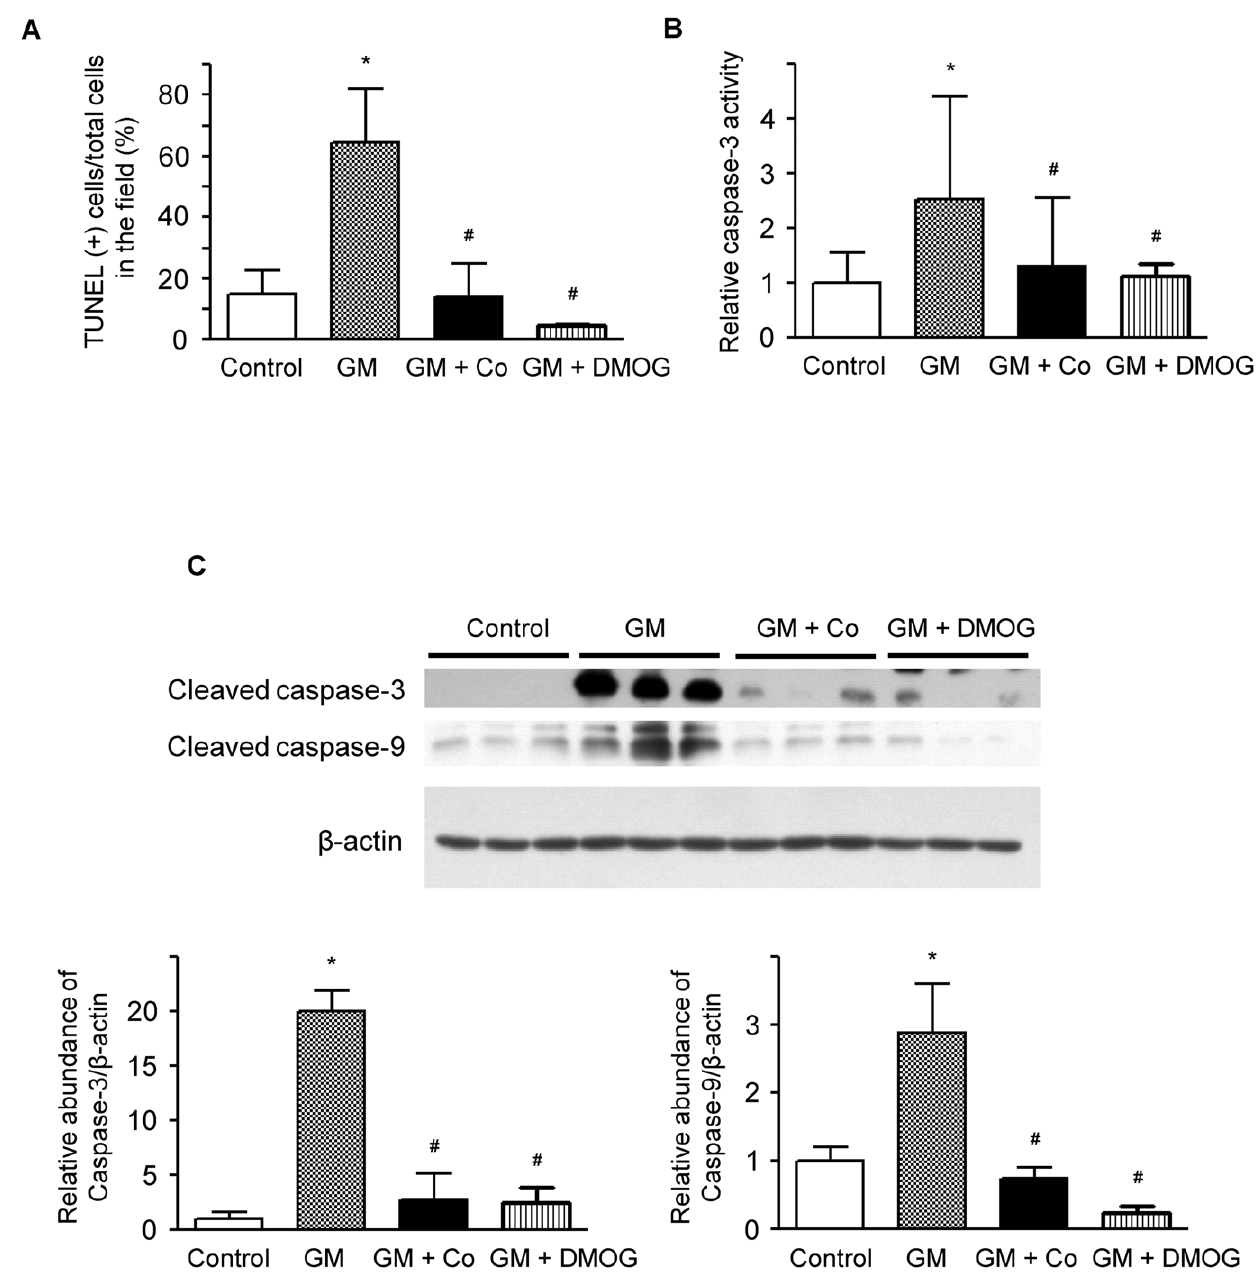
Figure 2. Effects of cobalt or DMOG pre-treatment on gentamicin-induced apoptosis in HK-2 cells. (A) The protective effect of cobalt or DMOG against gentamicin-induced apoptosis in HK-2 cells. The level of apoptosis is presented as the percentage of TUNEL-positive cells among the total cells counted in the field. (B) Effects of cobalt or DMOG on caspase-3 activity in gentamicin-treated HK-2 cells. The cells were harvested, and the activity of caspase-3 was analyzed using ELISA. The caspase-3 activities of the cells are shown as the relative activities of the experimental groups compared with control cells. (C) Effects of cobalt or DMOG on caspase-3 and caspase-9 in gentamicin-treated HK-2 cells. Western blotting was performed with the specific antibody against cleaved caspase-3 and caspase-9. Beta-actin was used as a loading control. Densitometric ratios between caspase-3, 9 and b -actin of cells are shown as the relative ratios of experimental groups compared with control cells. A representative set of three independent experiments is shown. The results are expressed as the mean 6 s.d. *Significantly different with respect to control cells. # Significantly different with respect to gentamicin-treated cells. * # P , 0.05. GM, gentamicin treatment; GM + Co, cobalt pre-treatment and gentamicin treatment; GM + DMOG, DMOG pre-treatment and gentamicin treatment. counted in more than 20 consecutive fields under 6 200 magnifi- the percentage of the total cells counted. Additionally, TUNEL staining was performed on the kidney tissue of experimental cation. animals using the same kit. Cells with apoptotic nuclei were A caspase-3 activity assay was performed using of the Caspase- 3/CPP32 Fluorometric Assay Kit (BioVision, Mountain View,